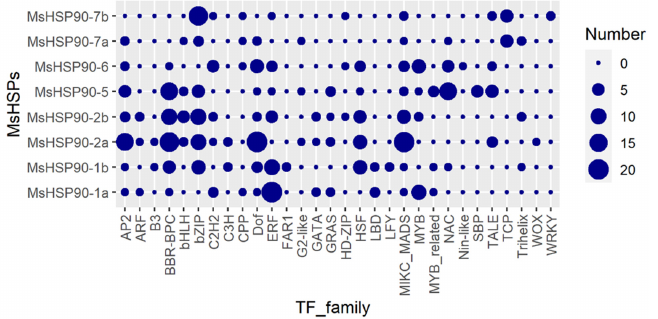
Figure 4. Prediction of potential transcription factors that binding sites of MsHSP90 genes. The promoter regions (within 2500 bp upstream of the coding region) of 8 MsHSP90 genes were obtained from the M. sieversii genome and analysed by PlantRegMap.3.3 tools (http://plantregmap.gao- lab.org/binding_site_prediction.php, accessed on 15 May 2021). Each dot represents the number of tran- scription factor binding sites in the MsHSP90 gene promotor region. Threshold p -value ≤ 1 × 10 − 5